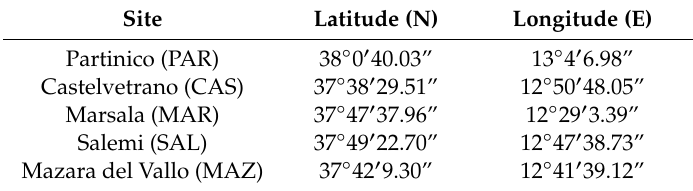
Table 1. The geographical location of agricultural sites in which disturbed soil was